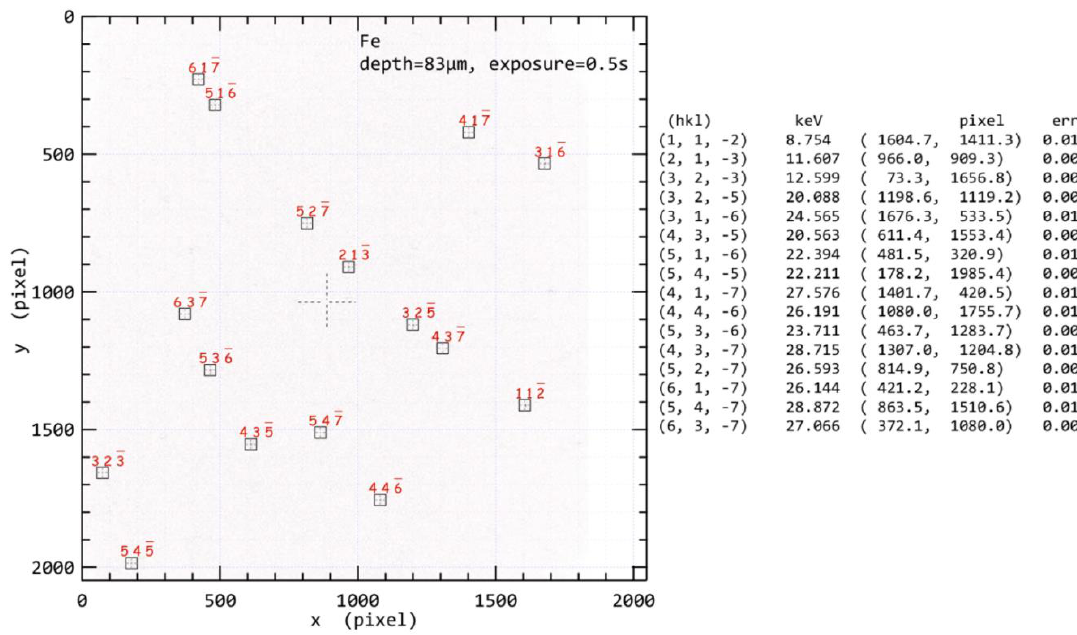
Figure 2. Example showing an indexed depth-resolved Laue diffraction pattern of a ferrite grain in ductile cast iron. The hkl indices, X-ray energies, peak positions, and fitting error of the indexing results are listed in the table to the right.